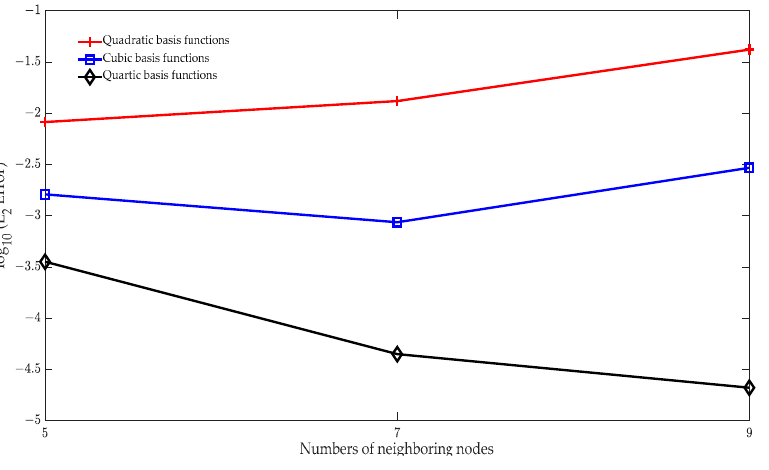
Figure 5. Convergence of L2 norms of displacement with a different number of neighboring nodes and order of